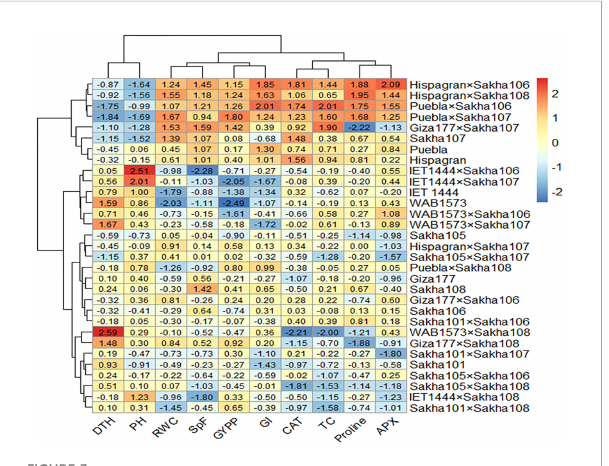
FIGURE 3 Heatmap showing the relationship between genotypes and the studied traits under normal conditions based on standardized data.